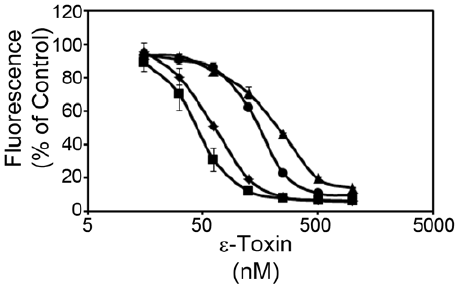
Figure 3. e -toxin-induced cytotoxicity in caveolin-2-deficient N cells. ACHN cells ( X ), or ACHN cells stably transfected with gene- ) and CAV2 – 56 ( m )] were specific shRNA [GAPDH ( & ), CAV2 – 53 ( incubated with serial dilutions (15.6 to 1000 nM toxin) of purified e -